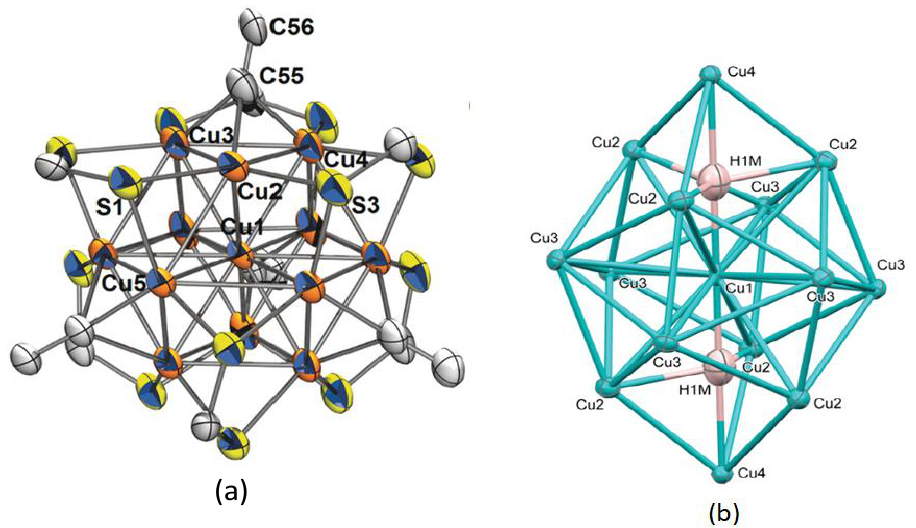
Figure 14. ( a ) Molecular suture of [Cu 13 ( µ 4 -S 2 CNR 2 ) 6 ( µ 3 -C ≡ CR) 4 ] + and ( b ) cluster core geometry of [Cu 15 (H) 2 (S 2 CNR 2 ) 6 (C≡CPh) 6 ] + . Reproduced with permission from [110]. Copyright 2016 John Wiley and Sons.